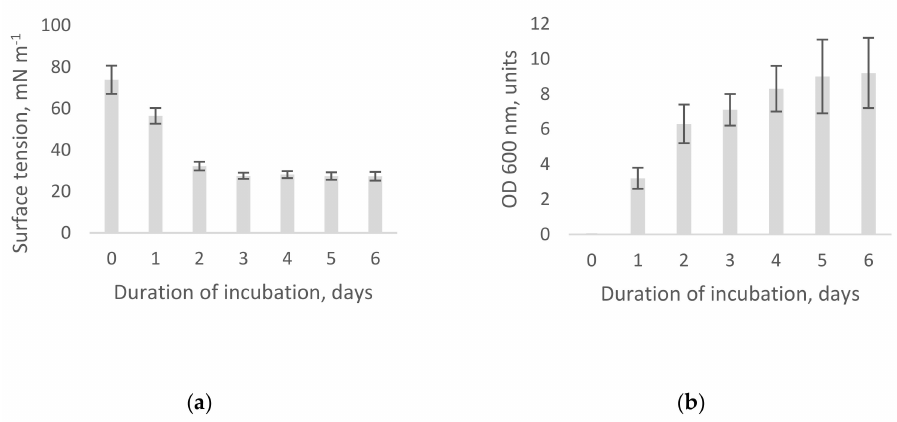
Figure 2. Surface tension of ( a ) and optical density ( b ) of the P. putida PP021 cultural